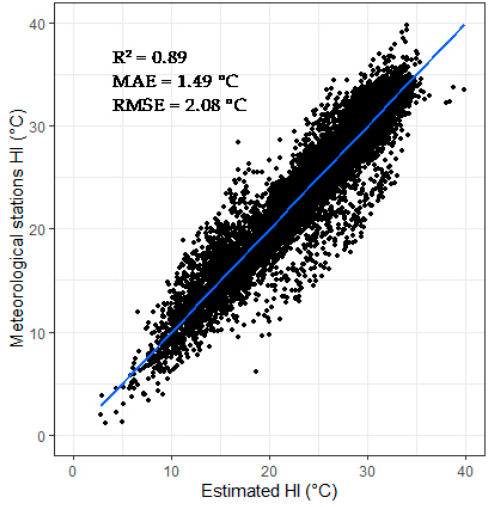
Figure 4. Correlation analysis between the estimated and meteorological station HI values.